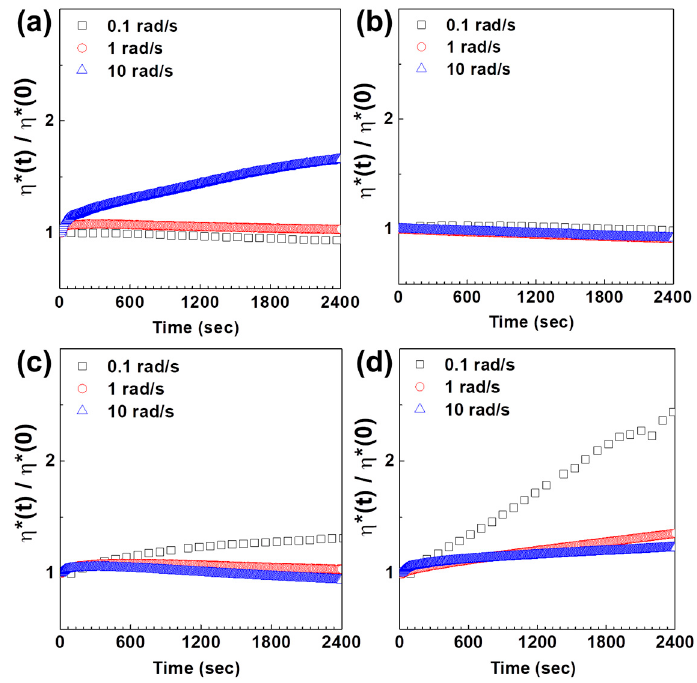
Figure 3. Time dependence of the normalized viscosity ( η * (t) / η * (0)) of PC / ABS with blend ratio of ( a ) 10:0, ( b ) 9:1, ( c ) 7:3 and ( d ) 0:10 at constant frequencies.